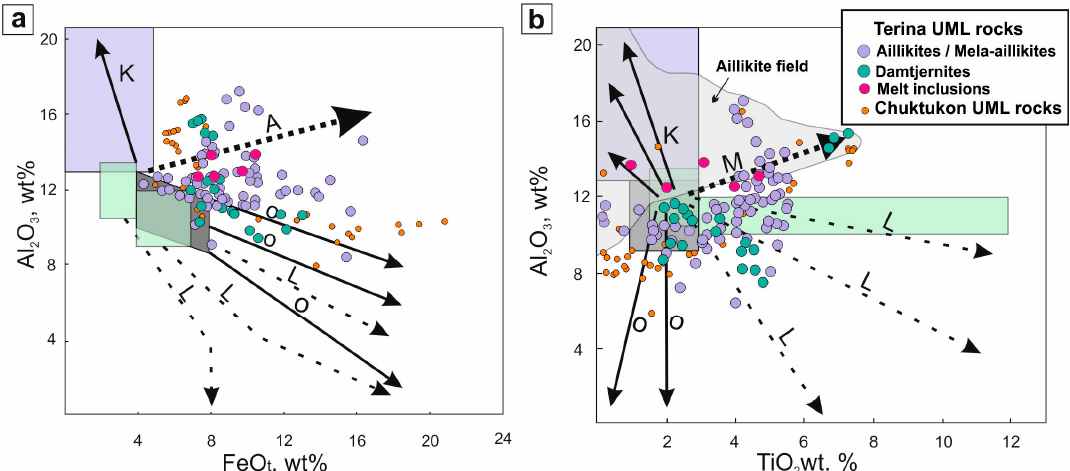
Figure 6. Compositional trends of micas from the Terina and Chuktukon complexes [7] UML rocks: K—kimberlite trends, O—orangeite trends, L—lamprophyre trends, M—menette trend [33]. The aillikite field is presented according to [6]. Diagrams of the variation in Al 2 O 3 vs. FeO t ( a ) and TiO 2 ( b ).